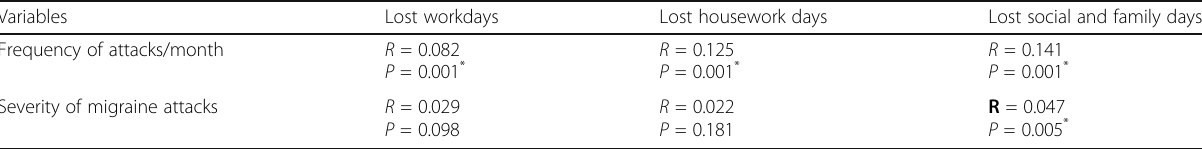
Table 3 Impact of migraine attacks assessed by HALT questionnaire in preceding 3 months Variables Lost workdays